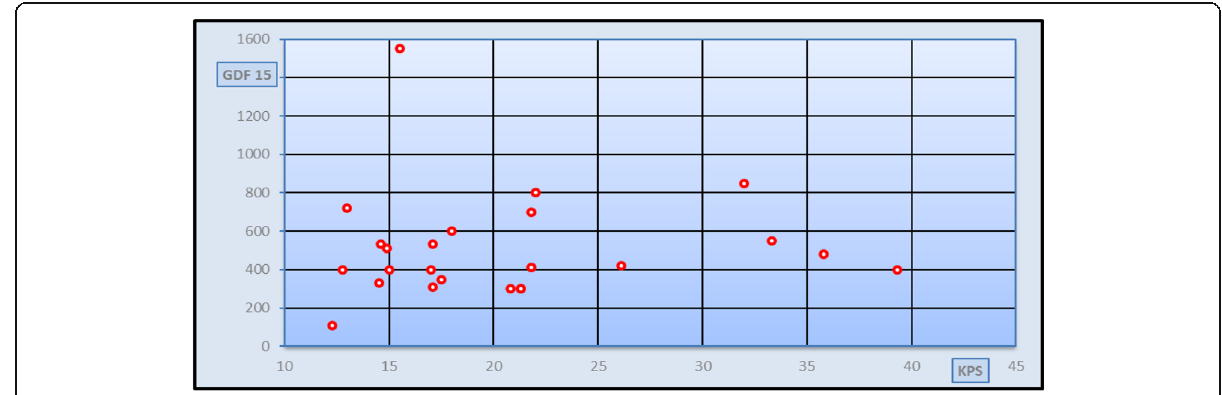
Fig. 4 Correlation study between GDF-15 and fibroscan in KPS in group III patients [ r = 0.203 and p = 0.342